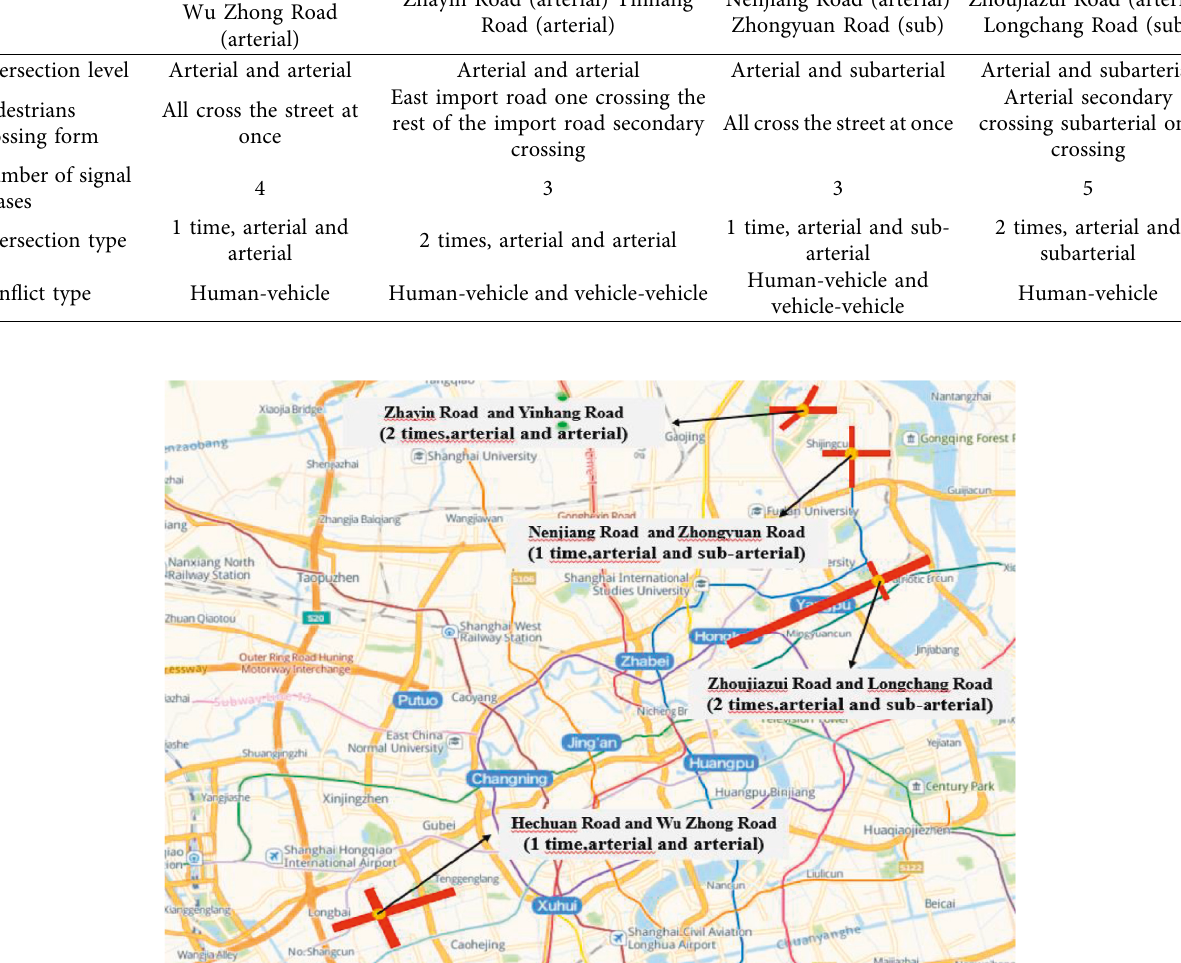
Figure 9: Location distribution of intersections at arterial in case study. (Source: